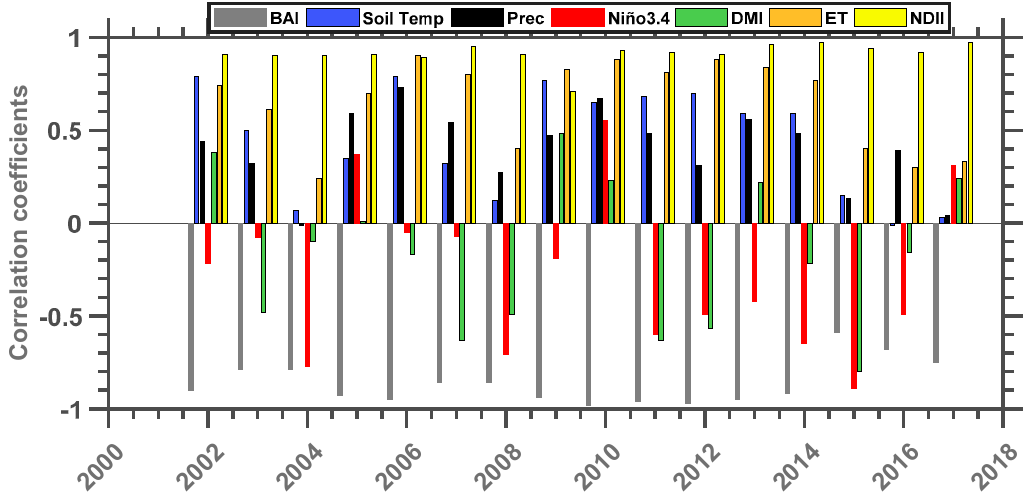
Figure 8. The inter-annual variability of linear correlations between NDVI and BAI, Soil Temp, Prec, Niño3.4, DMI, ET, and NDII for the period 2002 to 2017.